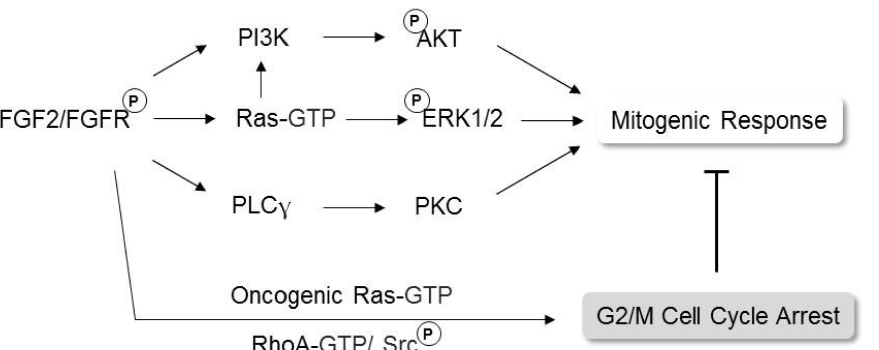
Figure 7. Proposed mechanism for the cytostatic effects of FGF2 in malignant cells transformed by Ras. FGF2 normally activates FGF receptors that trigger mitogenic responses. However, in Ras-transformed cells, FGF2 activates anti-proliferative mechanisms that are dependent on the Ras oncogene, active RhoA and Src tyrosine kinases, which ultimately trigger G2/M cell cycle arrest and senescence.